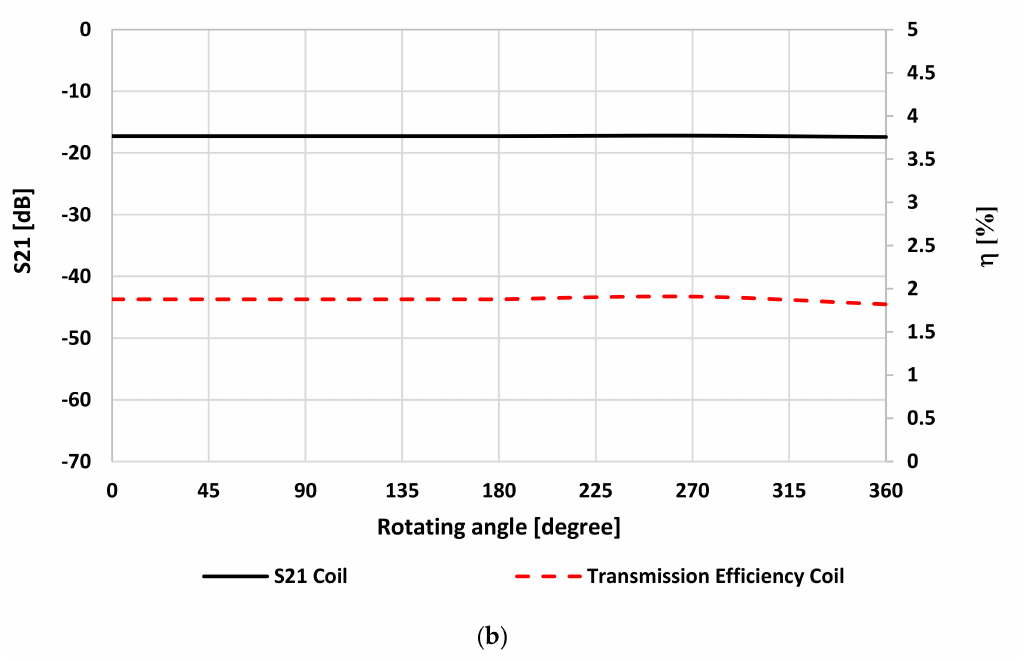
Figure 3. S 21 and η under rotational misalignment for the IM around z axis (the IM was at 30 mm depth) for ( a ) the antenna pair and ( b ) the coil pair.